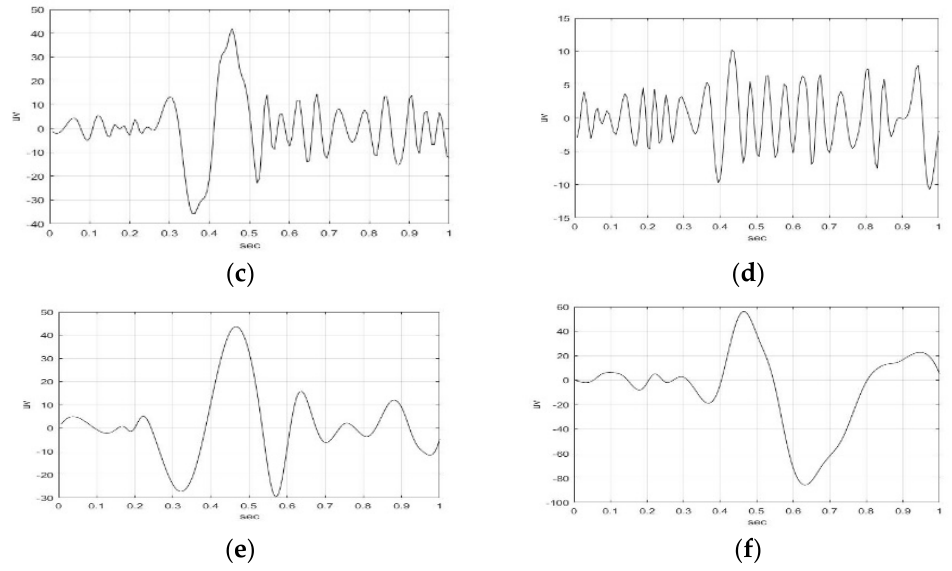
Figure 3. IMF1-IMF3 of F5AM and F5MI sample 1 EEG signals, respectively. ( a ) F5AM IMF1, ( b ) F5MI